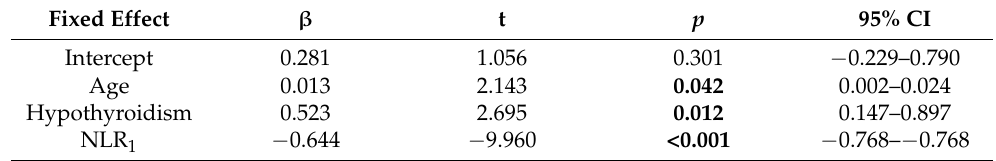
Table 6. Summary of the fixed effects of the final model for ∆ NLR (model F ). Fixed